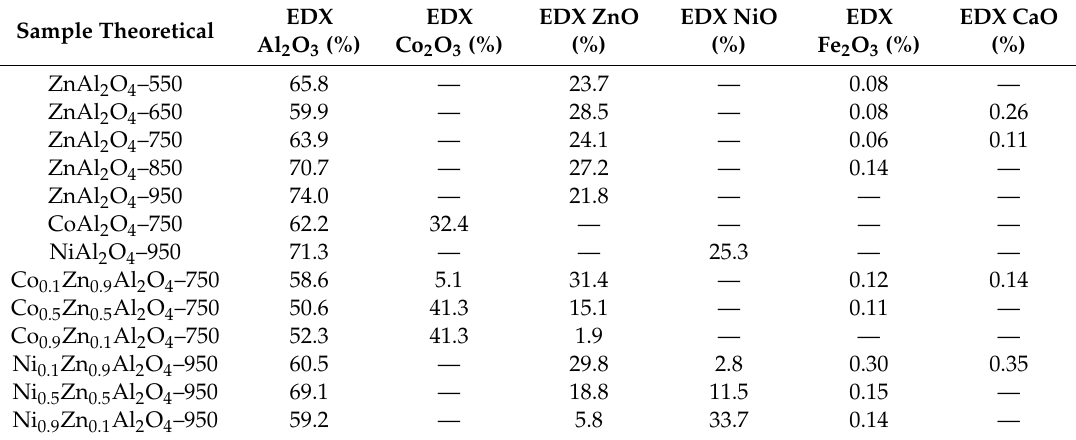
Table 2. X-ray fluorescence spectroscopy quantification and energy dispersion spectroscopy. Sample